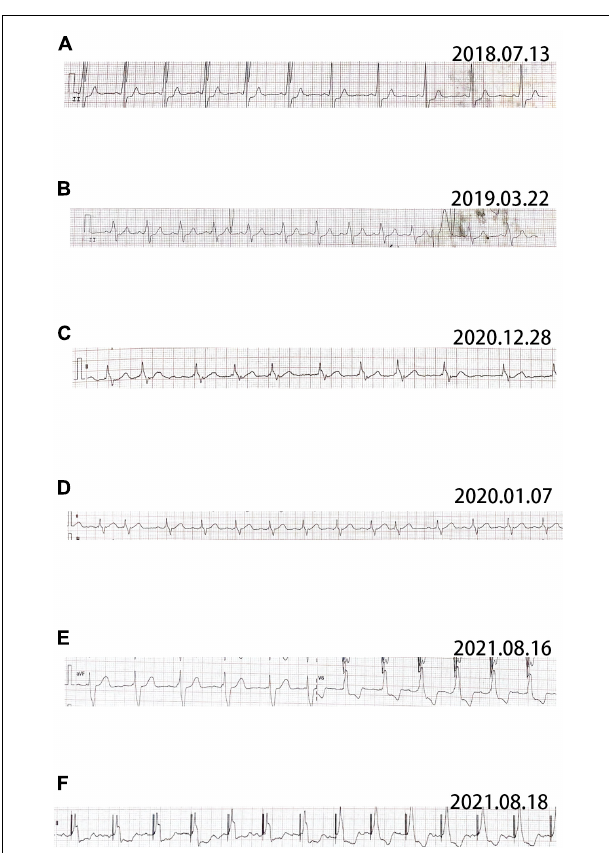
FIGURE 3 | ECG of patient 2. (A) The earliest ECG of patient showing sinus rhythm and complete left bundle branch block (CLBBB) with the width of QRS wave of 150 ms. (B) Sinus rhythm, CLBBB and frequent ventricular premature beat. (C) Atrial fibrillation and CLBBB. (D) Recovered sinus rhythm after radiofrequency ablation. (E) The pre-operative ECG showing sinus rhythm, CLBBB and 220 ms of QRS wave width. (F) Post-operative ECG showing sinus rhythm and 190 ms of QRS wave